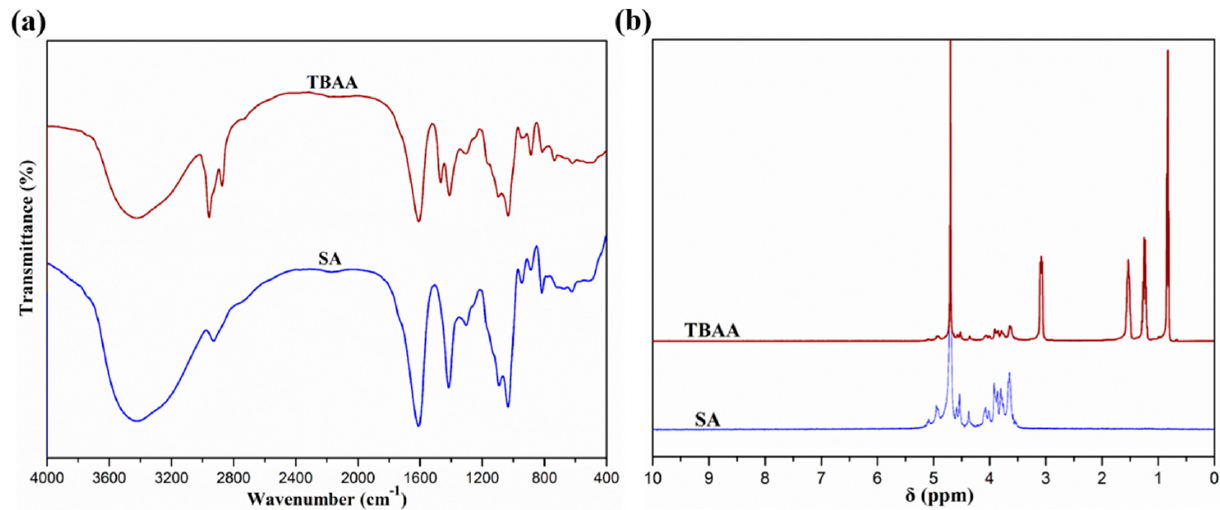
Figure 1. ( a ) FT-IR and ( b ) 1 H NMR spectra of SA and TBAA. To investigate the effects of alkyl groups with different lengths of carbon chain (hexyl, octyl, decyl, and lauryl groups) on the physicochemical properties of AAD, the HAD, OAD, DAD, and LAD were synthesized using the corresponding alkyl halides with the N Alkyl bromide /N Hexuronic molar ratios fixed at 0.5 via the S N 2 reaction. The reaction pa- rameters for the synthesis of AAD with different DS and yields are presented in Table 1. It can be observed that the DS of HAD, OAD, DAD, and LAD was close to 40%. Meanwhile, to prepare different DS of HAD, various N 1-Bromohexane /N Hexuronic molar ratios were per- formed to achieve the chemical modification. The different DS and yields of HAD with the N 1-Bromohexane /N Hexuronic values of 0.3, 0.5, and 1.2 are also presented in Table 1. It can be seen that the DS and yield of HAD increased with the increase of N 1-Bromohexane /N Hexuronic values. Even when the N 1-Bromohexane /N Hexuronic molar ratio was 1.2, the DS of HAD reached approximately 100%. This result directly indicated that the S N 2 reaction for the chemical modification of SA was active. To note, it was reported that the AAD grafted with the alkyl chains was able to associate to form self-aggregated micelles through both intra- and intermolecular hydrophobic interactions [21]. However, these properties were obtained only within a narrow range of DS. At low DS, AAD was not enough to drive its self-aggregation, while at high DS, the polymer derivatives were no longer soluble in water [37]. For this reason, we selected the AAD with the DS close to 40% to develop the hydrophobic pharmaceutical formulations. Figure 2a represents the FT-IR spectra of SA, HAD, OAD, DAD, and LAD. Compared with the spectrum of SA, HAD, OAD, DAD, and LAD exhibited the additional weak bands in addition to the basic characteris37tic absorption bands of SA. The absorption bands of HAD, OAD, DAD, and LAD at 2930, 2928, 2927, and 2926 cm − 1 were significantly enhanced, and were ascribed, respectively, to the stretching vibration of –CH 3 on the hexyl, octyl, decyl, and lauryl groups. Furthermore, the additional bands appearing at 2860, 2860, 2858, and 2926 cm − 1 were assigned, respectively, to the –CH 2 – stretching vibration of the hexyl, octyl, decyl, and lauryl groups. In addition, the additional bands appearing at 1741, 1741, 1741, and 1740 cm − 1 were owing to stretching vibration of C=O on the ester group, while the other new bands appearing at 1244, 1245, 1243, and 1244 cm − 1 were attributed to the stretching vibration of C–O on the ester group [29]. These results indicated that